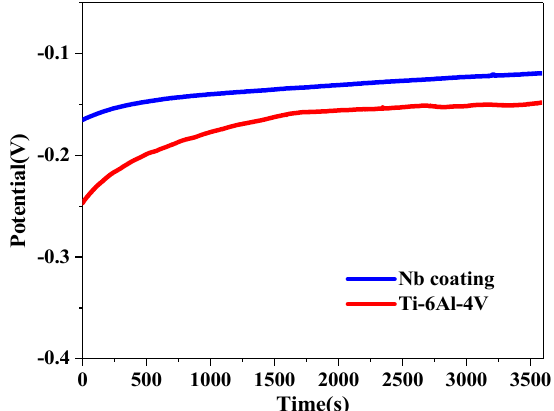
Figure 4. Open circuit potential versus time curves of the niobium coating and the Ti–6Al–4V substrate in Ringer’s solution at 37 °C.